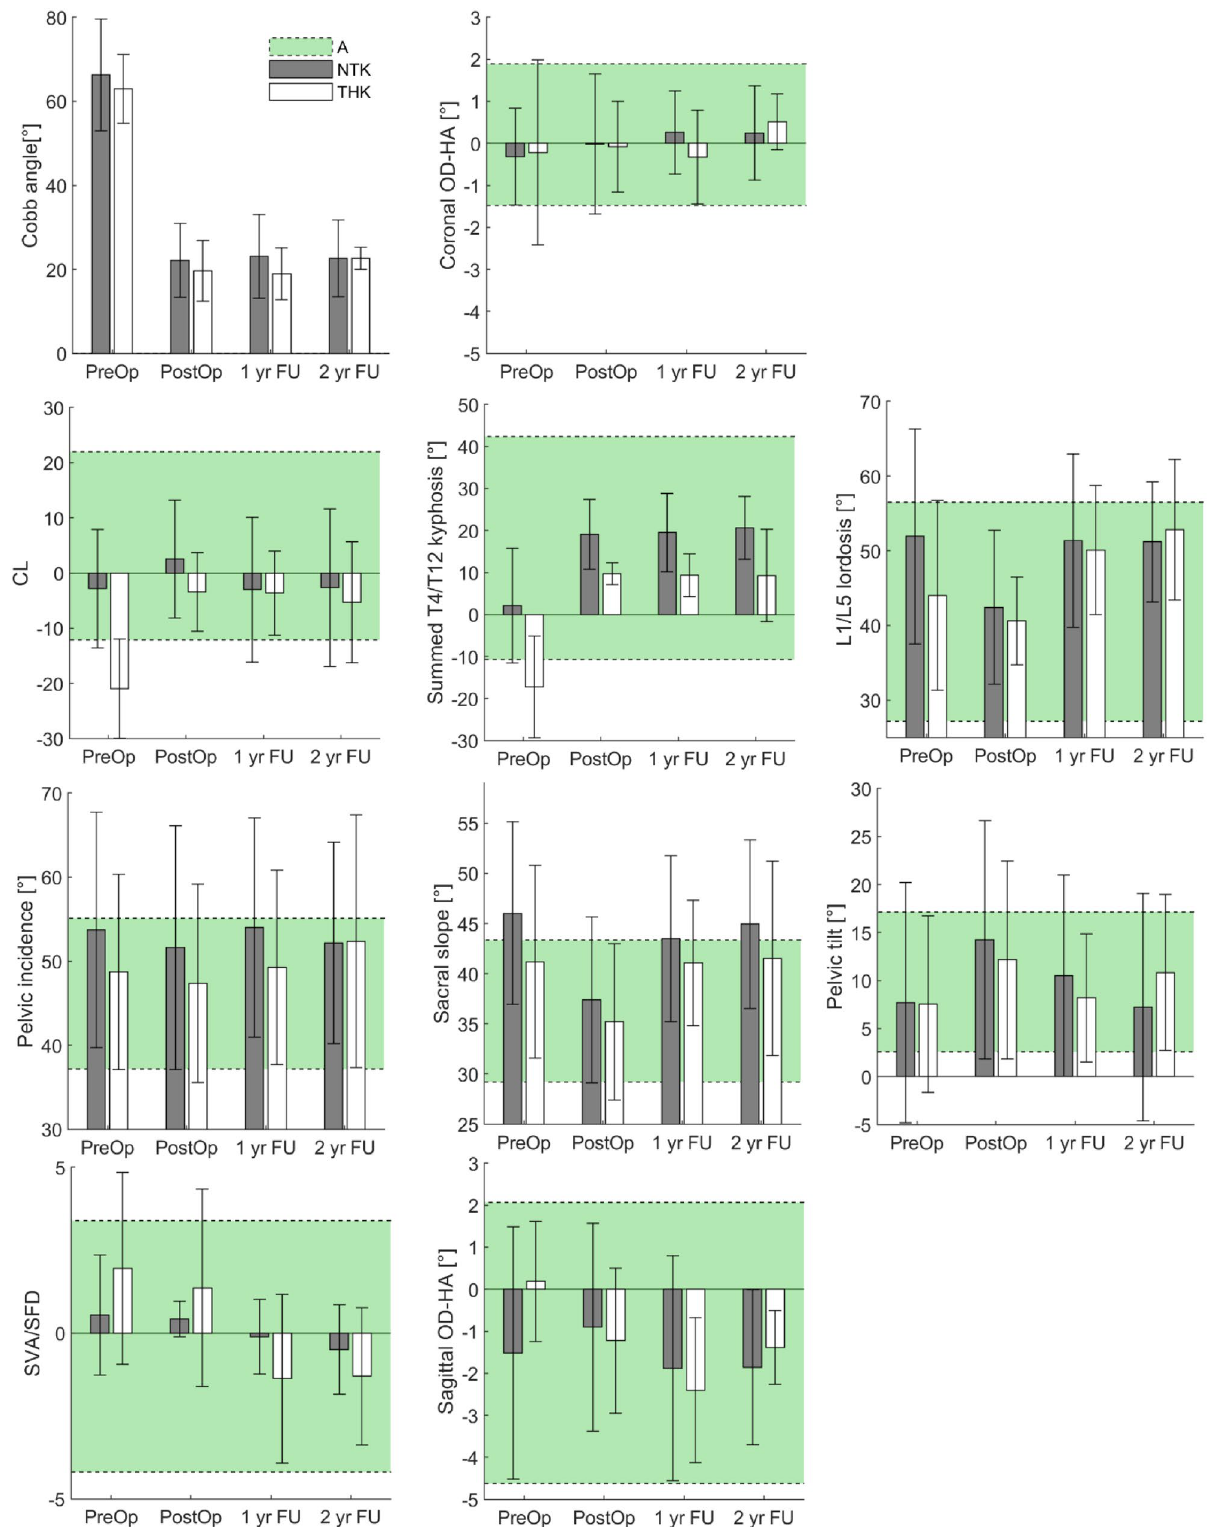
Figure 2. Main results comparing asymptomatic subjects (A, green shaded areas representing average ± 2*standard deviation), normal thoracic kyphosis patients (NTK, mean ± 2SD) and thoracic hypokyphosis patients